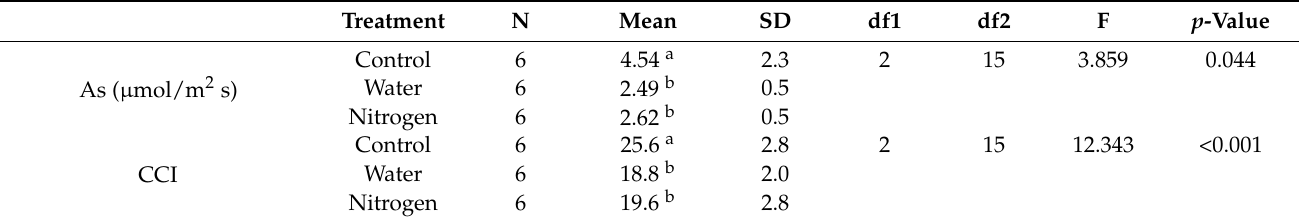
Table 4. Results of the statistical analysis comparing the physiological parameters of the plants and the growth environment of the three treatments (Control, Water, and Nitrogen). The columns rep- resent the sample size (N), mean values (Mean), standard deviation (SD), and degrees of freedom between the groups (df1) and within the groups (df2), F − test (F), and level of significance ( p − value).